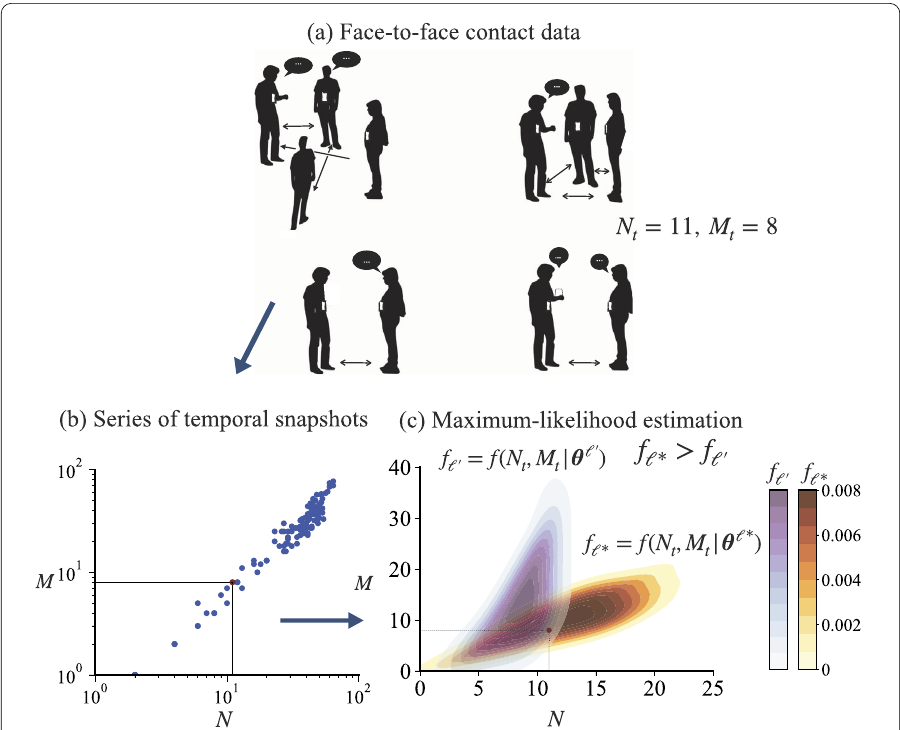
Figure 2 Schematic of maximum-likelihood estimation of κ and N p . The top panel shows contact data that gives a combination ( N t , M t ). The sequence { ( N t , M t ) } T t =1 is plotted in the N - M space, in which a particular combination of (11,8) is highlighted in red (bottom left). The joint distributions of ( N , M ), or likelihood functions, are generated using the hidden-variable model for different combinations of ( κ , N p ) = θ , with each indexed by (cid:6) (cid:7) and (cid:6) ∗ (bottom right). A likelihood function gives the probability of observing a network with N nodes and M edges, for a given combination of ( κ , N p ). The maximum-likelihood estimators, denoted by (cid:6) κ t and (cid:6) N p , t , are given by a combination of κ and N p associated with the maximum-likelihood function ∗ f (cid:6) ∗ = f ( N t , M t | θ (cid:6) )